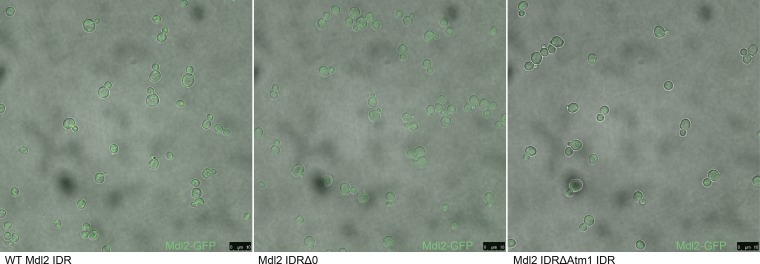
Micrographs of S. cerevisiae strains with three different genotypes.From left to right: Mdl2-GFP has a mitochondrial localization in the wildtype (WT) strain, knocking out the Mdl2 IDR abolishes wildtype localization, and replacing the Mdl2 IDR with that of Atm1 rescues mitochondrial localization.